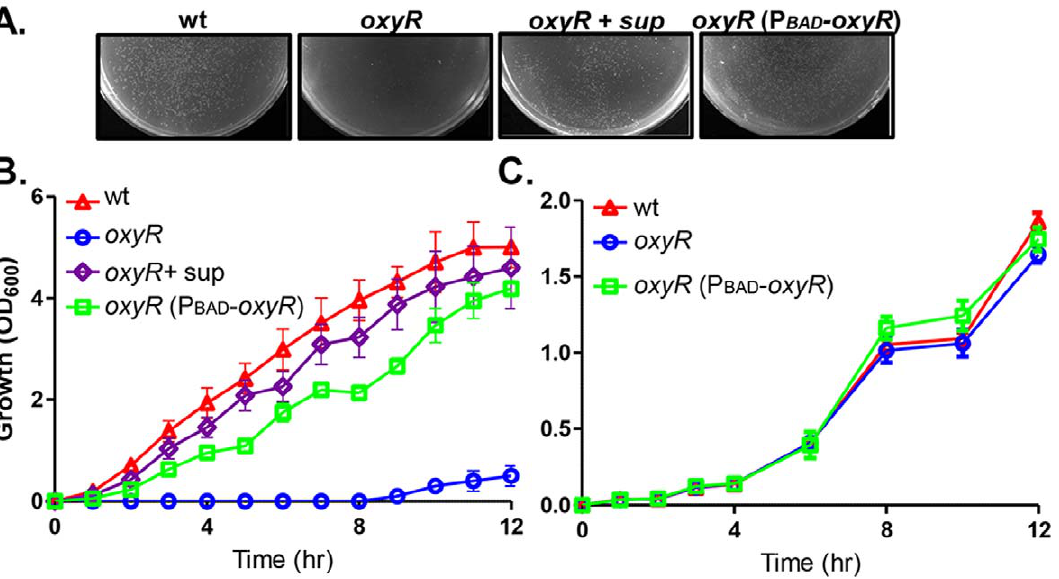
Figure 1. Growth of oxyR mutants in the absence and in the presence of stationary-phase cultural supernatants. A. Wildtype, oxyR mutants, and oxyR (P BAD -oxyR ) grown on LB agar plates containing 0.01% arabinose without and with 1/10 (v/v) cell-free supernatants (see Methods for preparation) after overnight incubation at 37 u C. B. and C. Wildtype, oxyR mutants, and oxyR (P BAD -oxyR ) grown in LB liquid ( B ) and M9 minimal medium ( C ). Overnight cultures were inoculated 1:1000 into fresh LB or M9-glucose medium containing 0.01% arabinose without and with 1/10 (v/v) cell-free supernatants and shaken at 37 u C. OD 600 was measured at the time points indicated. Data are mean and s.d. of three independent